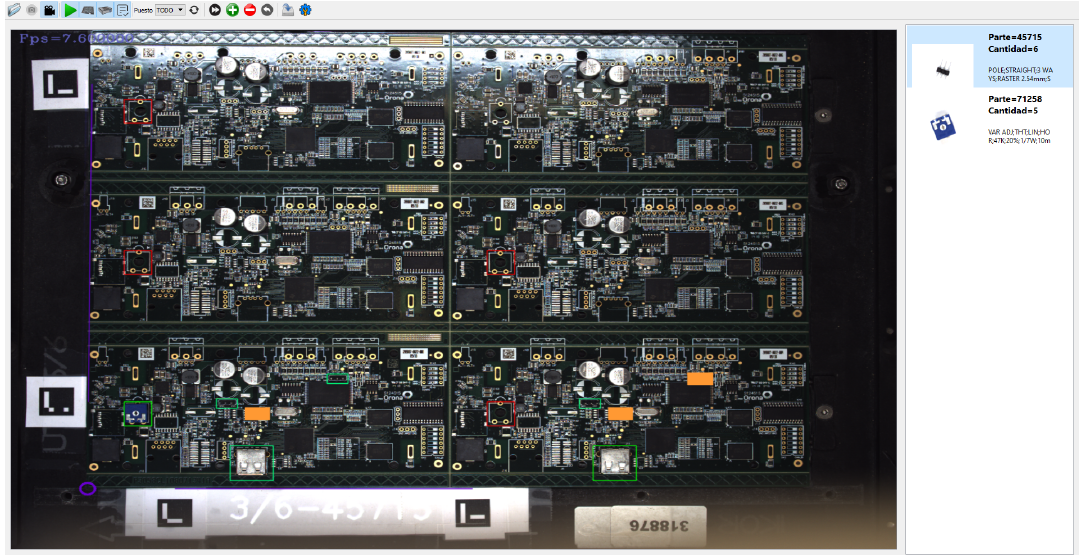
Figure 4. Screen visualization of the current state of the